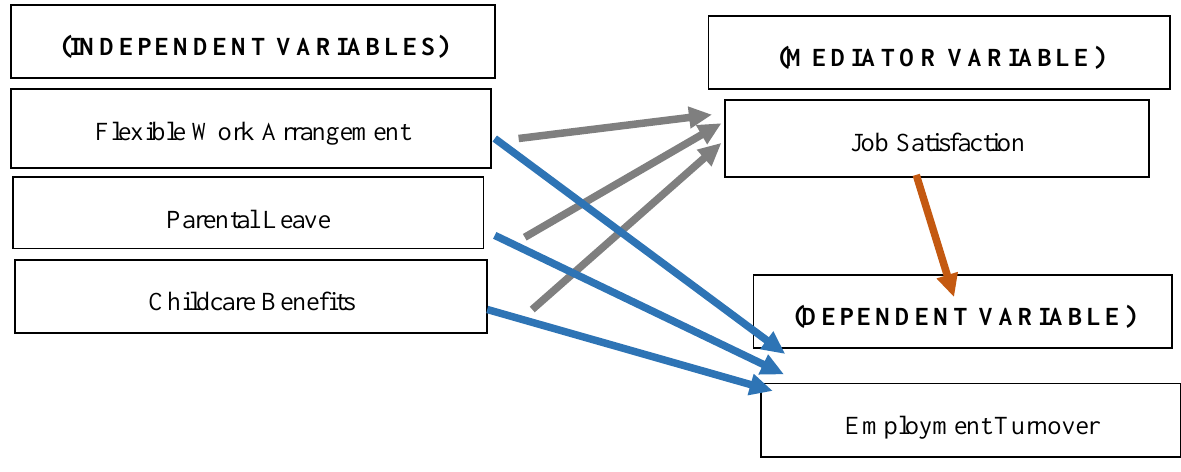
Figure 1. Paradigm Showing Relationship Between Dependent and Independent